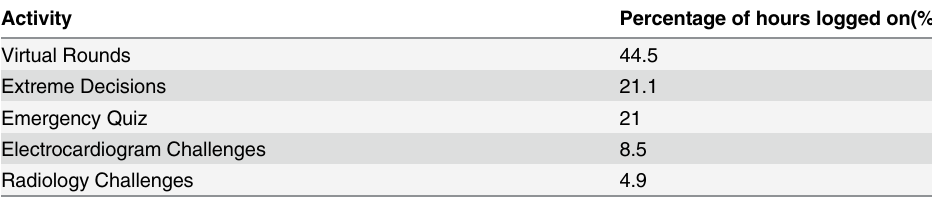
Table 3. Proportional students´ participation on each activity.